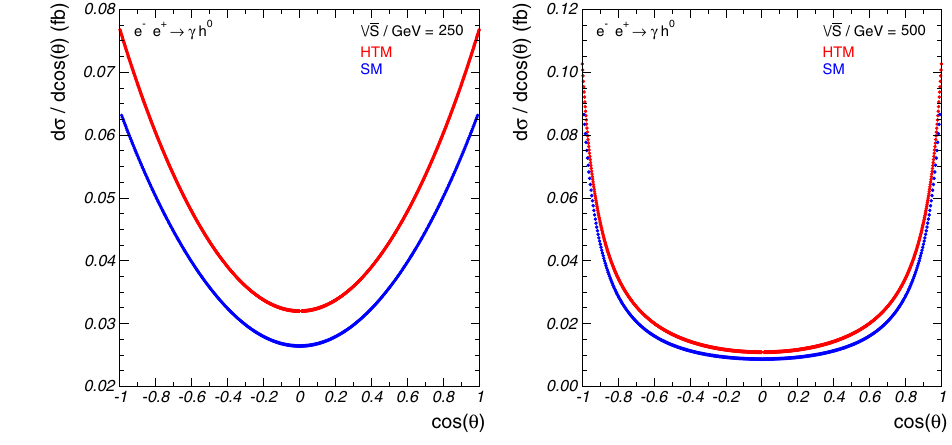
. The middle (resp. right) side shows the distribution of the transverse momentum, p h 0 Z √ s = 250,300 and 500 GeV, we fix here (λ 1 ,λ 4 ) = ( − 0 . 35 , + 0 . 61 )